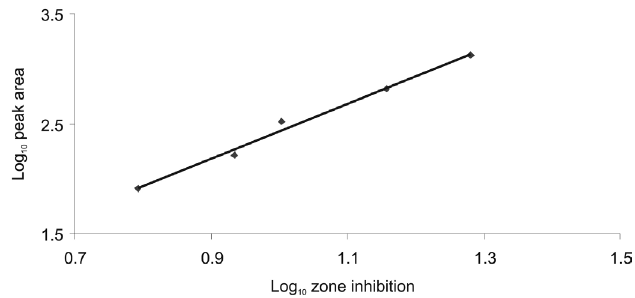
FIGURE 3 - Correlation between HPLC and bioassay: The figure demonstrates the agreement between the responses of the two tested methods ( r =